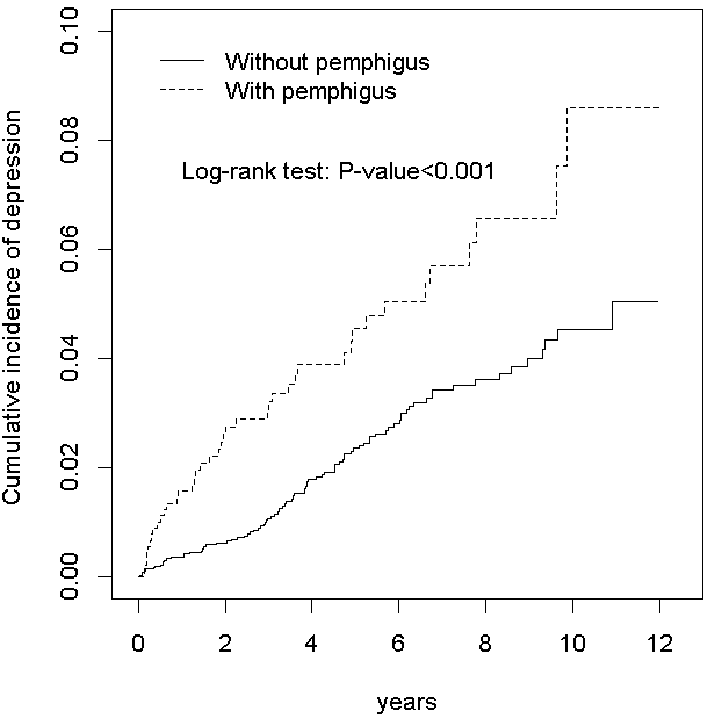
Figure 1. Cumulative incidence of depression between individuals with and without pemphigs.